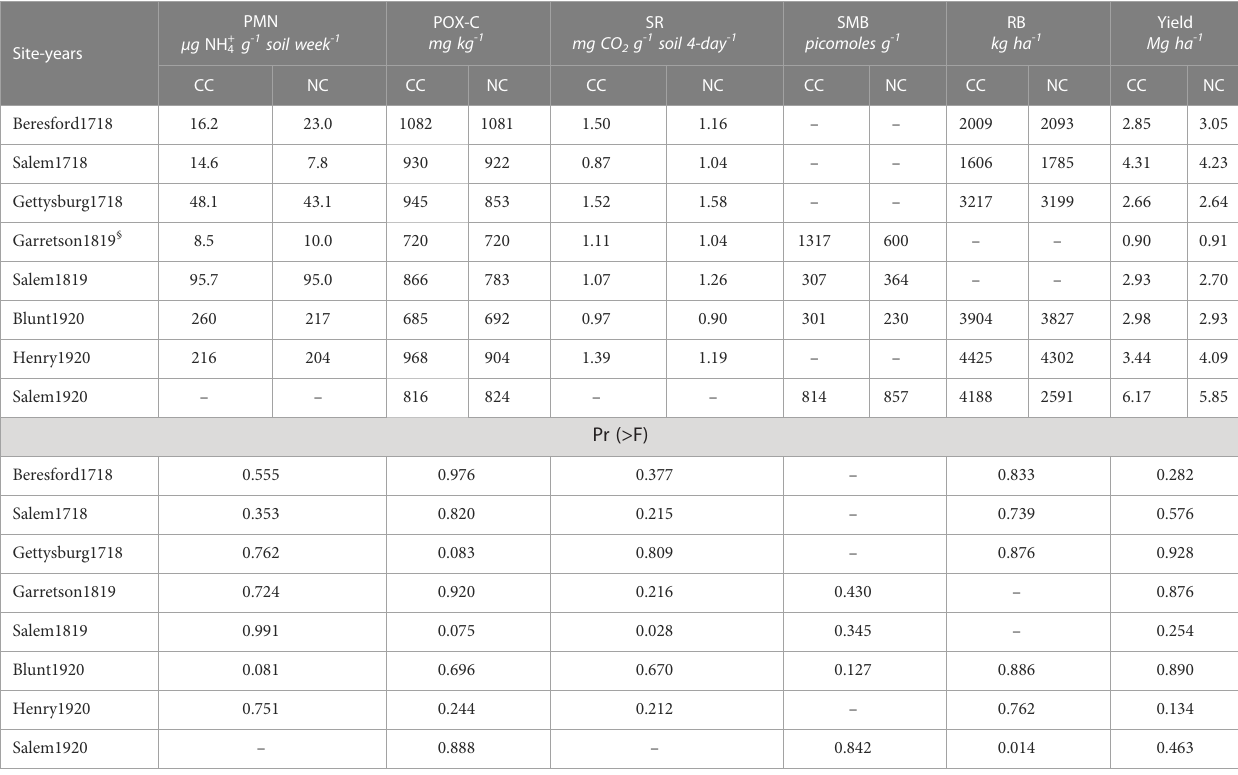
TABLE 3 Site-year-wise mean values of selected soil health indicators such as potentially mineralizable nitrogen (PMN; µg NH + 4 g -1 soil week -1 ), active carbon or permanganate oxidizable carbon (POX-C; mg kg -1 ), soil respiration (SR; mg CO 2 g -1 soil 4-day -1 ), soil microbial biomass (SMB, picomoles g -1 ), residue biomass (RB, kg ha -1 ), and cash crop yields (Mg ha -1 ) under cover crop and no cover control plots for eight site-years in South Dakota.